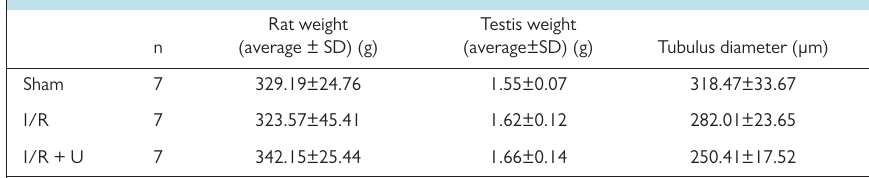
Table 1. Evaluation of parameters for each group